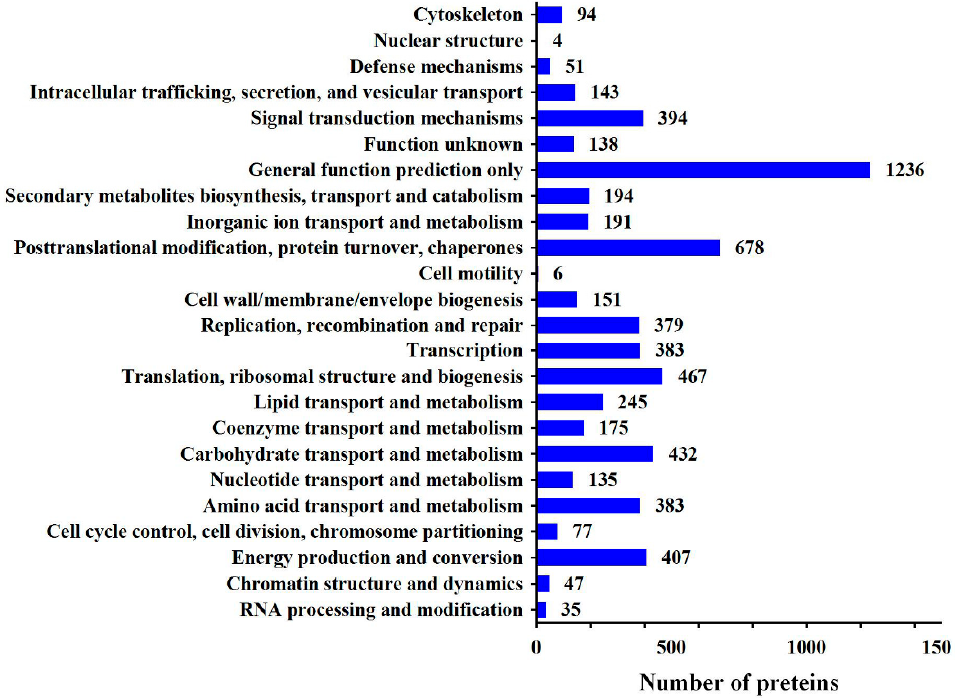
Figure 3. ( A ) Spectra, peptides, and proteins identified from isobaric tags for relative and absolute quantitation (iTRAQ) proteomics. ( B ) Molecular weight distribution of the proteins that were identified from the iTRAQ analysis.